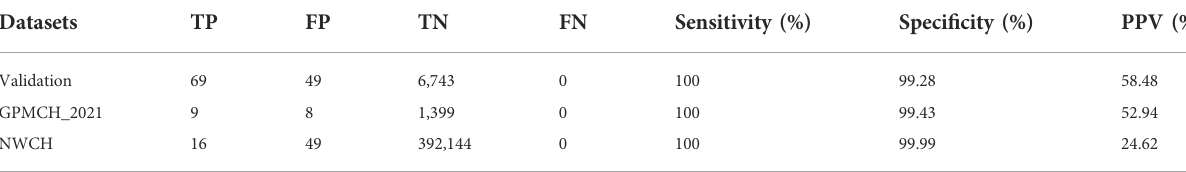
TABLE 3 Validation of our model.